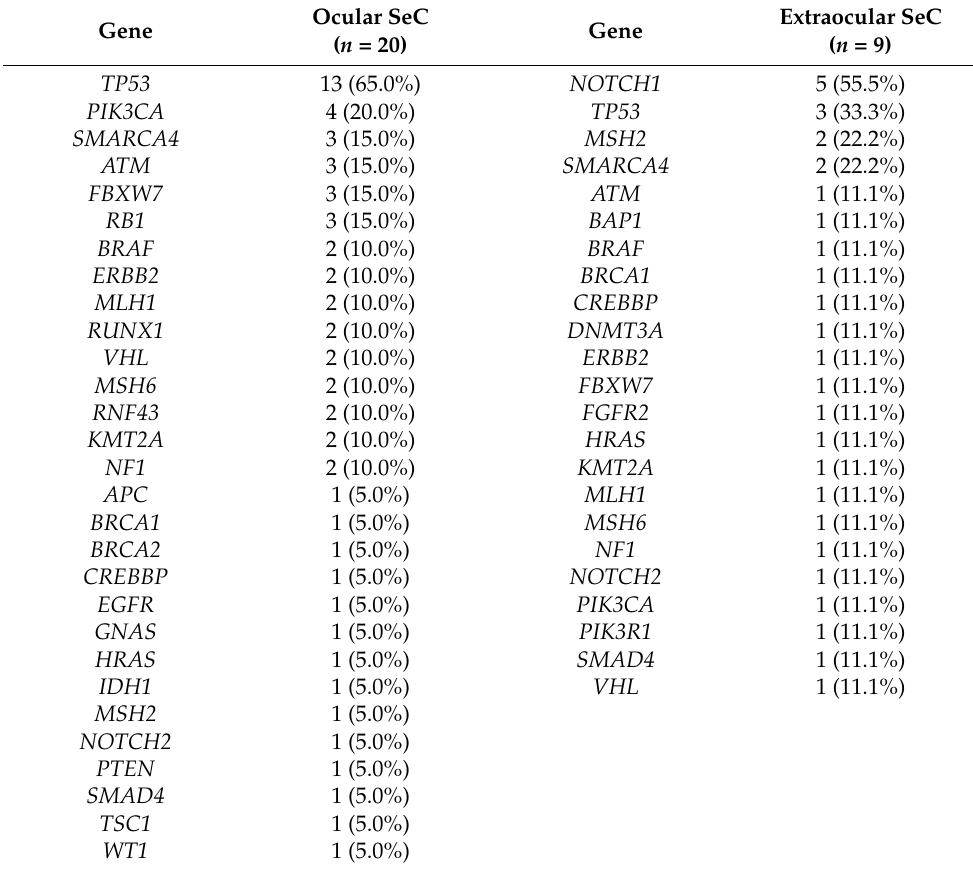
Table 2. List of genes that harbor mutations in ocular and extraocular sebaceous